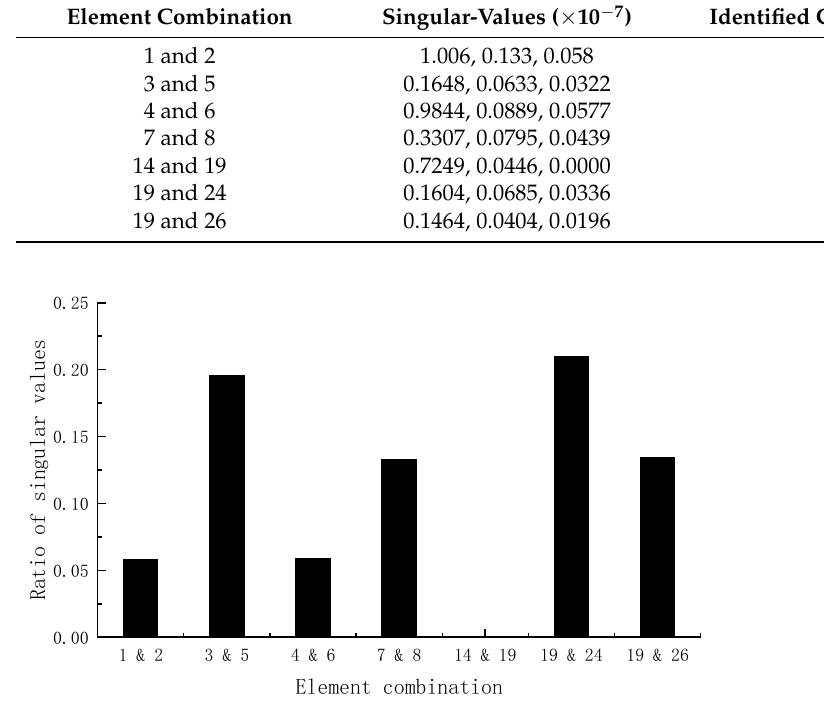
Figure 5. The singular-value ratio graph obtained by Table 4 when elements 14 and 19 are damaged (no noise).